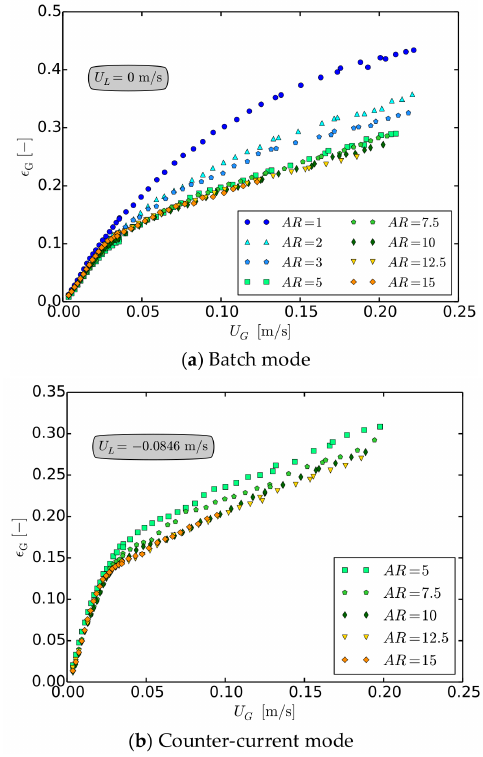
Figure 19. Influence of AR in large diameter bubble columns with spider sparger—data from ref.